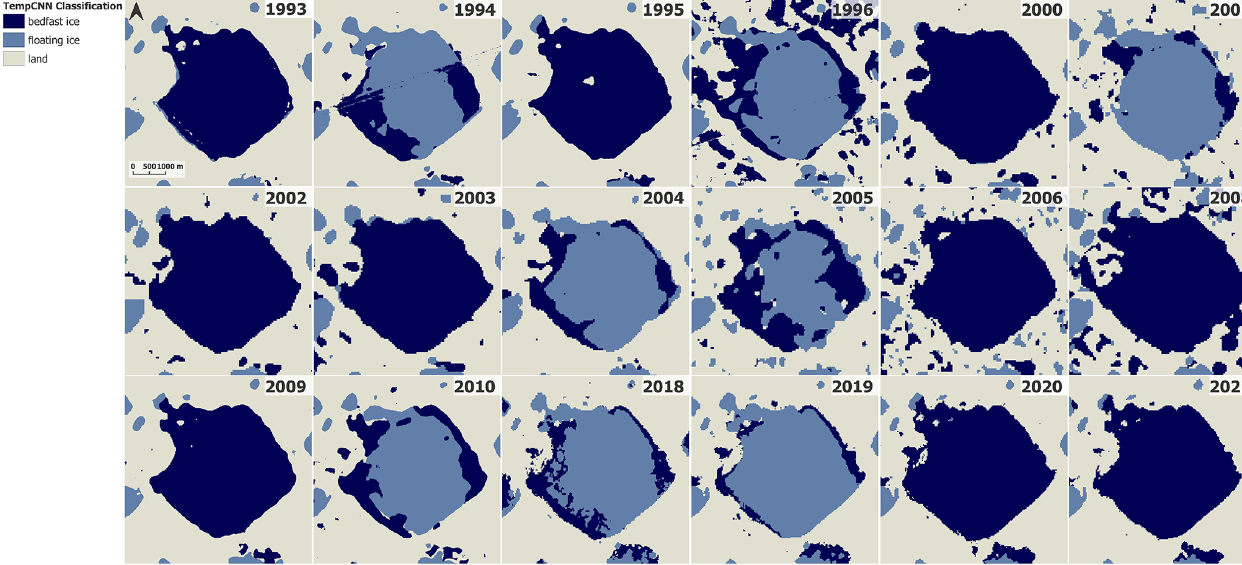
Figure 10. Husky Lake TempCNN-predicted ice regime (1992/1993–2020/2021). Dark blue represents bedfast ice; light blue – floating ice; grey – land. Ice regime fluctuates between floating and bedfast depending on snow conditions, water level, and air temperature.